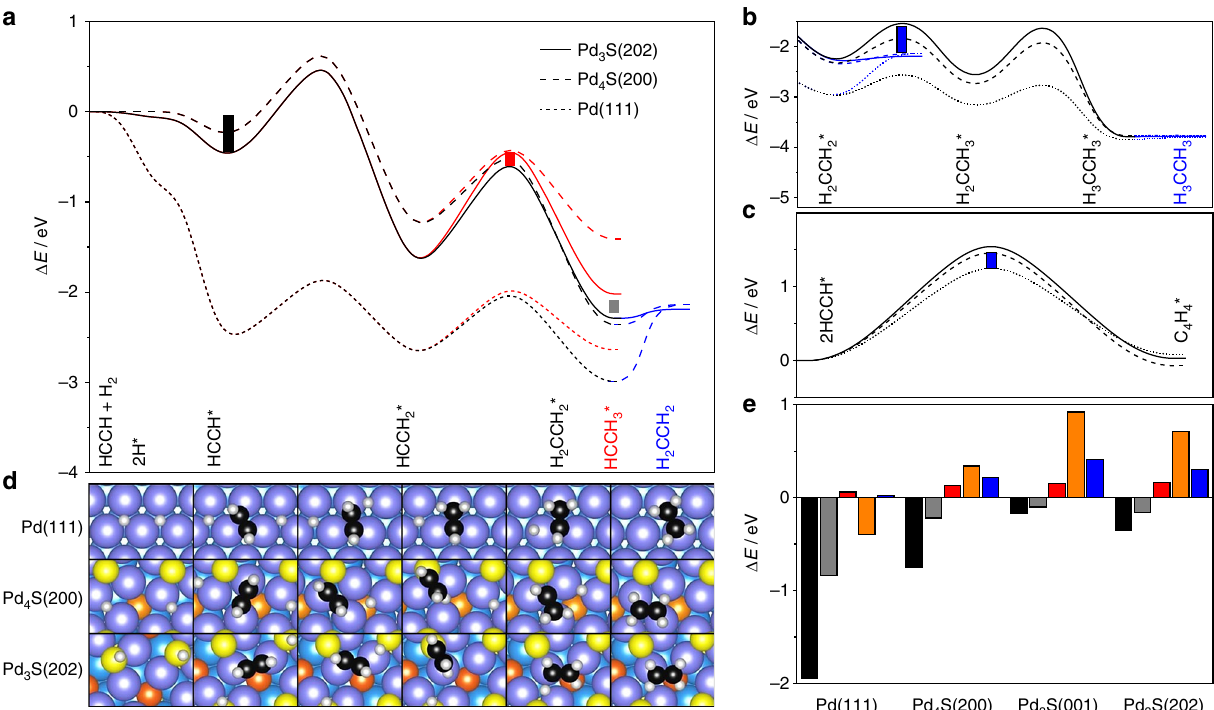
Fig. 5 Density functional theory reaction analysis. a – c Energy pro fi les for the semi-hydrogenation ( a ), over-hydrogenation ( b ), and oligomerization ( c ) of acetylene on Pd 3 S(202), Pd 4 S(200), and Pd(111). The asterisks denote adsorbed species, the color of the pro fi le matches that of the possible intermediate, and the bars relate to the energy differences for Pd 3 S(202) presented in e : HCCH adsorption (black bars), H 2 CCH 2 desorption (gray bars), and the difference in activation energy between H 2 CCH 2 (ethene) and HCCH 3 (ethylidene) formation (red bars), H 2 CCH 2 desorption and H 2 CCH 3 formation (orange bars), and for oligomerization (blue bars). d Top view of the DFT-optimized adsorption con fi guration of the reaction intermediates and transition states (TS) on the surfaces. The elementary steps are shown in Supplementary Table 5. Color code as in Fig. 3, carbon (black), hydrogen